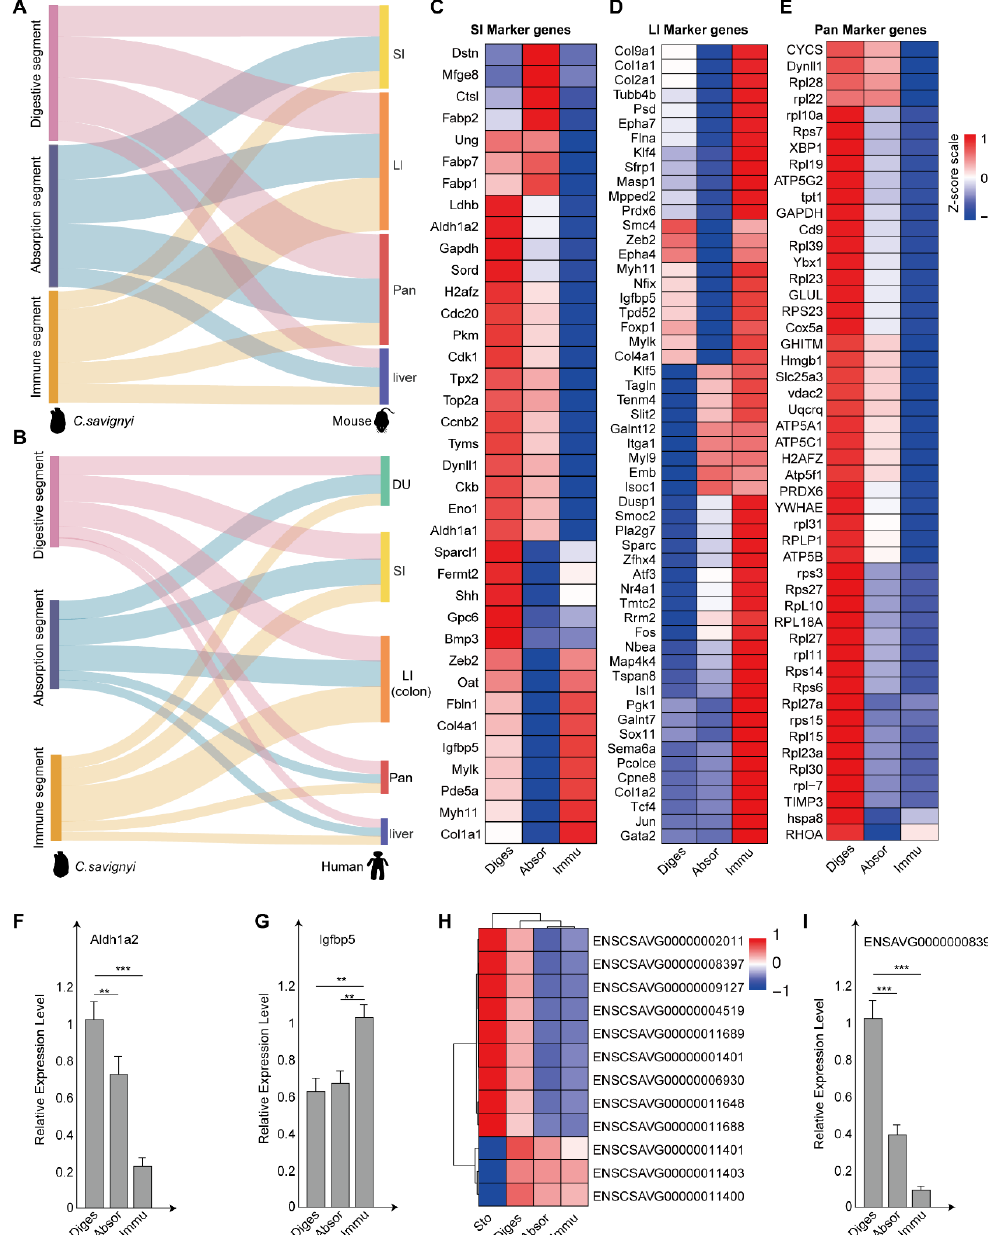
Figure 4. Comparison of the C. savignyi intestine with the digestive system of humans ( Homo sapiens ) and mice ( Mus musculus ). ( A , B ) Sankey plot showing the connectivity between the intestine of C. savignyi and the digestive system of Mus musculus ( A ) and H. sapiens ( B ). The thickness of the line represents the number of orthologous genes. ( C – E ) Heat map of expression of homologues of Mus musculus SI, LI, and Pan marker genes in C. savignyi stomach and different intestinal segments. The row Z-score was calculated by log 2 -transformed FPKM values of targeted genes. The formula to calculate row Z-scores from FPKM values was log 2 (FPKM + 1). The row Z-score value ranges from − 1 to 1 and is represented as a color-coded box, with red and blue indicating relative up − regulation and down − regulation, respectively. ( F , G , I ) qPCR con fi rms mRNA level of Aldhla2 (SI marker gene), lg fb p5 (LI marker genes), and TRYPSIN (Pan marker genes) ( H ) Gene expression heat map of pan markers genes in Sto, Diges, Absor, and Immu. Error bars represent standard deviation. *** p < 0.001 and ** p < 0.01 by Student’s t -test. (Sto: stomach, Diges: digestive segment, Absor: absorption segment, Immu: immune segment, DU: duodenum, SI: small intestine, LI: large intestine, Pan: pancreas).